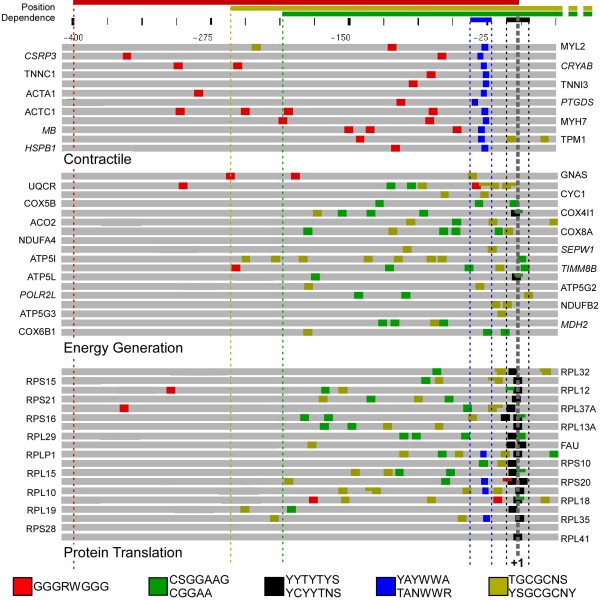
Specific patterns of top-scoring motifs in the promoter sequence of genes in either the contractile (top), energy generation (center), or protein translation (bottom) modules. Gray bars represent 435 bp of promoter and 5' UTR sequence (-400 → +35 bp). Colored boxes indicate occurrences of each motif using the color patterns shown in the legend (bottom). Occurrences are drawn to scale, and overlapping sites are drawn at half-height to ease viewing. The scale bar is given on the top, with numbers relative to the transcription start site (gray dashed line, +1 bp). Colored lines above the scale indicate the position range used for each motif. Note that the pyrimidine-rich sequence (black) is directly adjacent to the transcription start site in most genes of the translation module, but not in contractile or energy generation genes. Also note the complete absence of the CCGGAA (green) motif in the contractile promoter sequences. Instead, contractile promoters have a high proportion of a different G-rich motif (GGGRWGGG, red), occurring between -400 bp and the transcription start site.